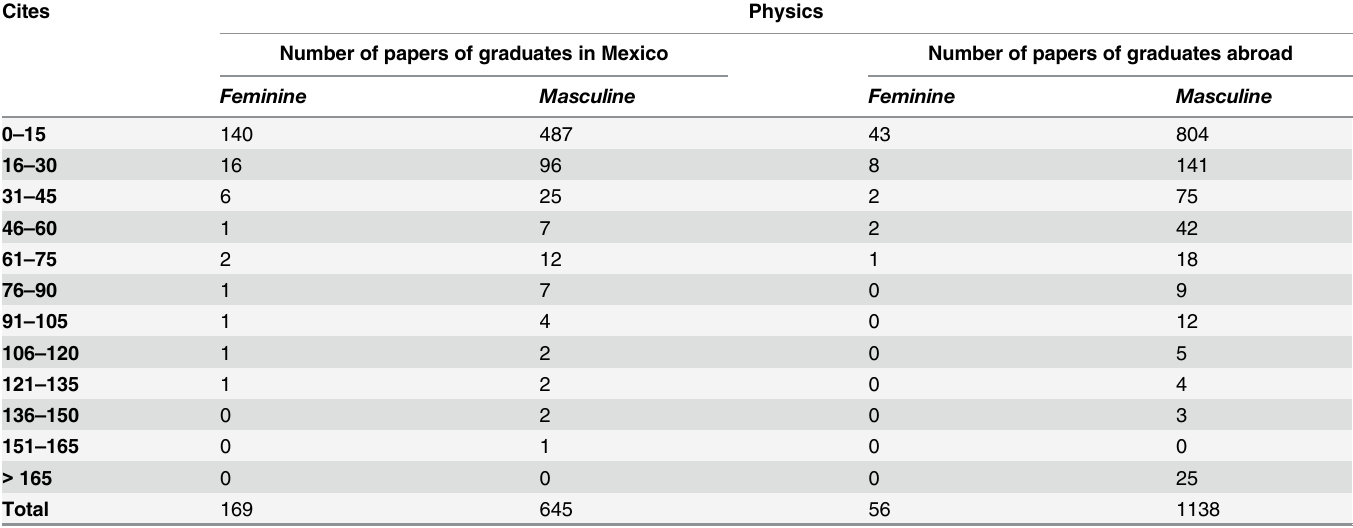
Table 10. Cites vs. number of papers published by the Mexican diaspora of physics by gender and country of PhD. Cites Physics Number of papers of graduates in Mexico